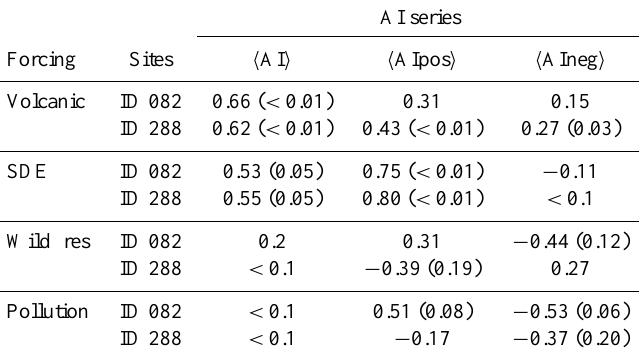
Table 1. Correlation coefficients between the variations of the AI and different forcing parameters: annual series in case of volcanic and pollution forcings, and summer series in case of SDE and wildfire forcings. Values in brackets are p values (only p values ≤ 0.2 are